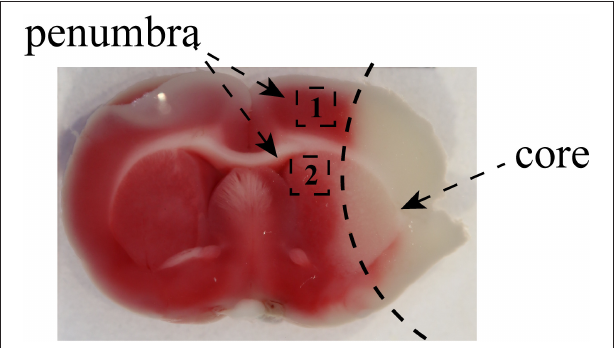
FIGURE 1 | The images of the penumbra after MCAO. The images showed that the black zone marked as “1” represented the selected cortex region near the infarct core and the area labeled as “2” was marginal striatum around the infarct core. We used the brain tissue from penumbra to perform qRT-PCR, Luminex multiplex assay, and Western blotting. The area of penumbra in the cortex and striatum for immunofluorescence staining was chosen as